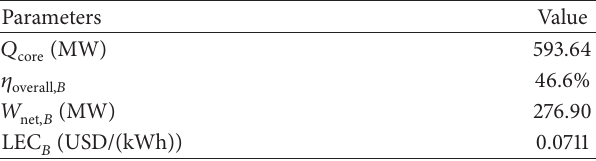
Table 6: Results of the closed Brayton cycle.